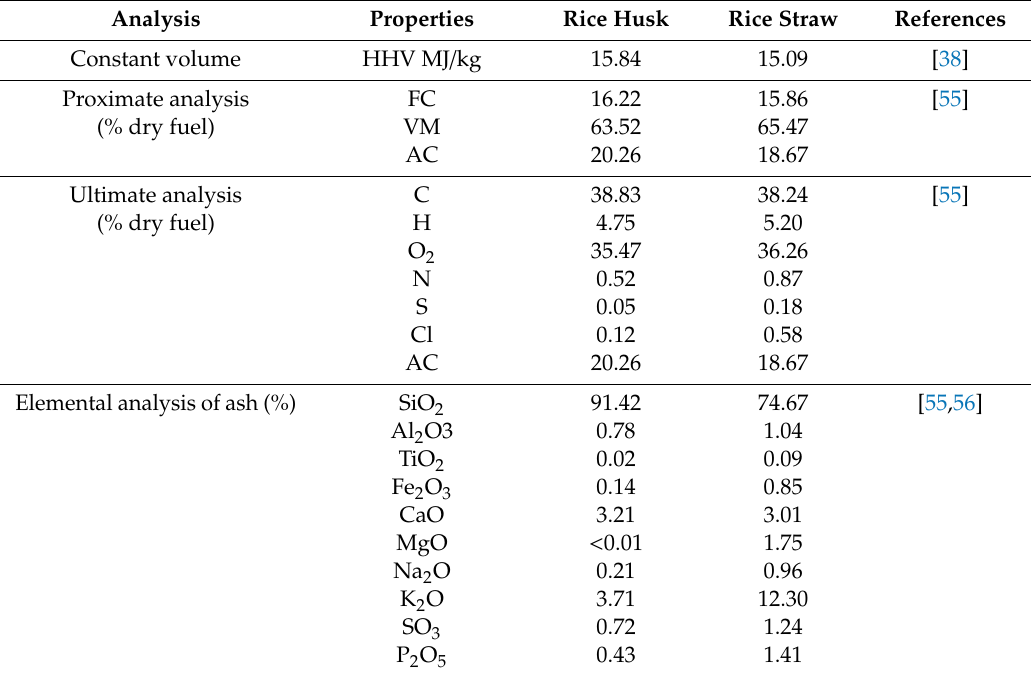
Table 2. Properties of rice crop